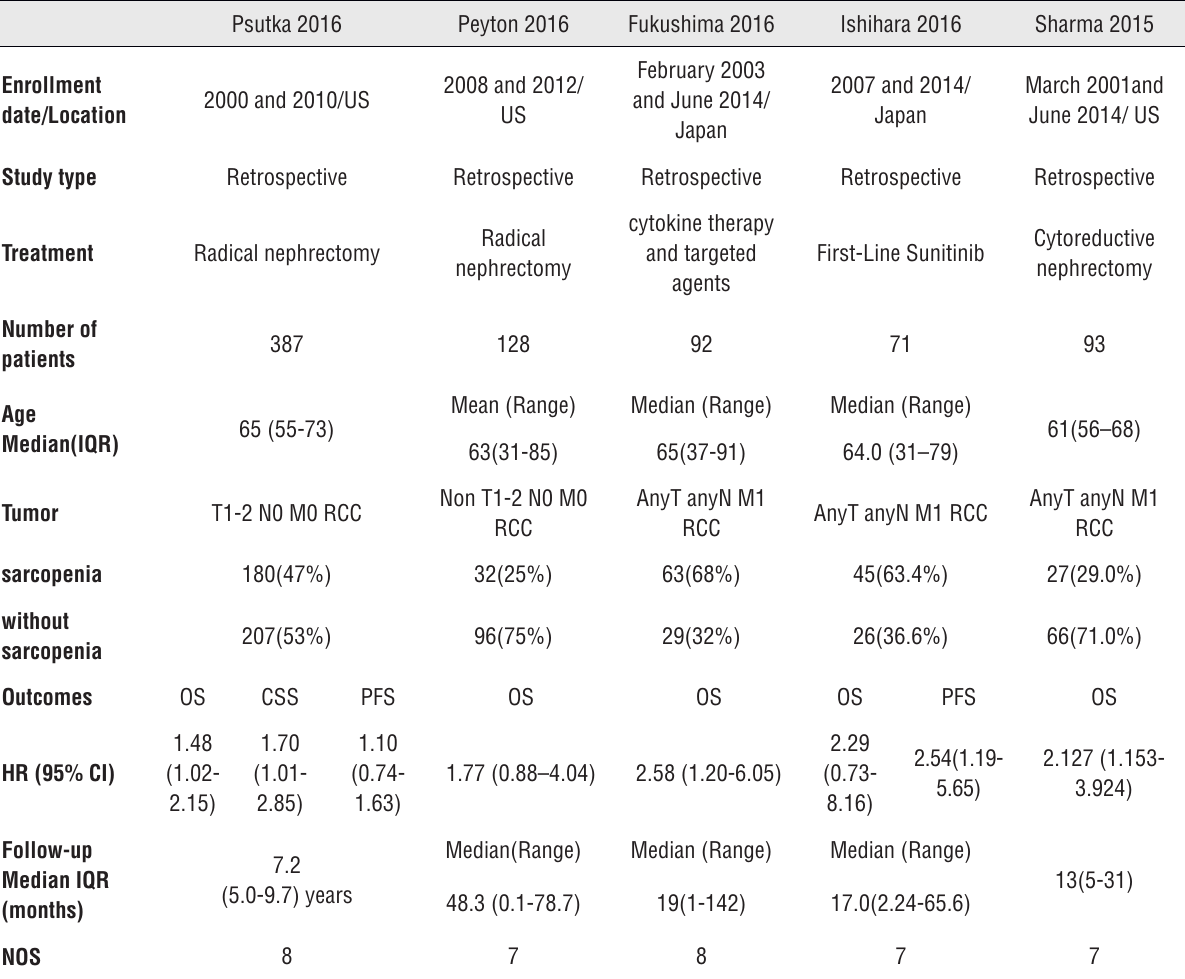
Table 1 - Characteristic of included